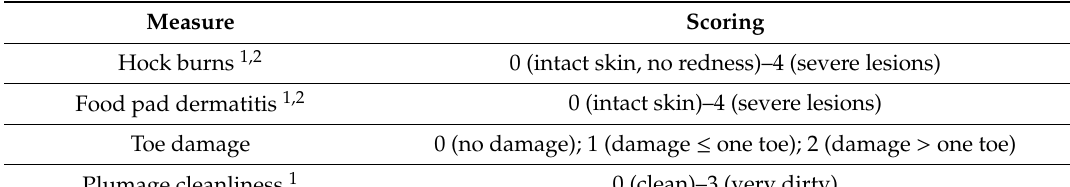
Table 1. Scoring protocol for on-farm clinical examination and gait scoring of commercial organic broiler chickens (including